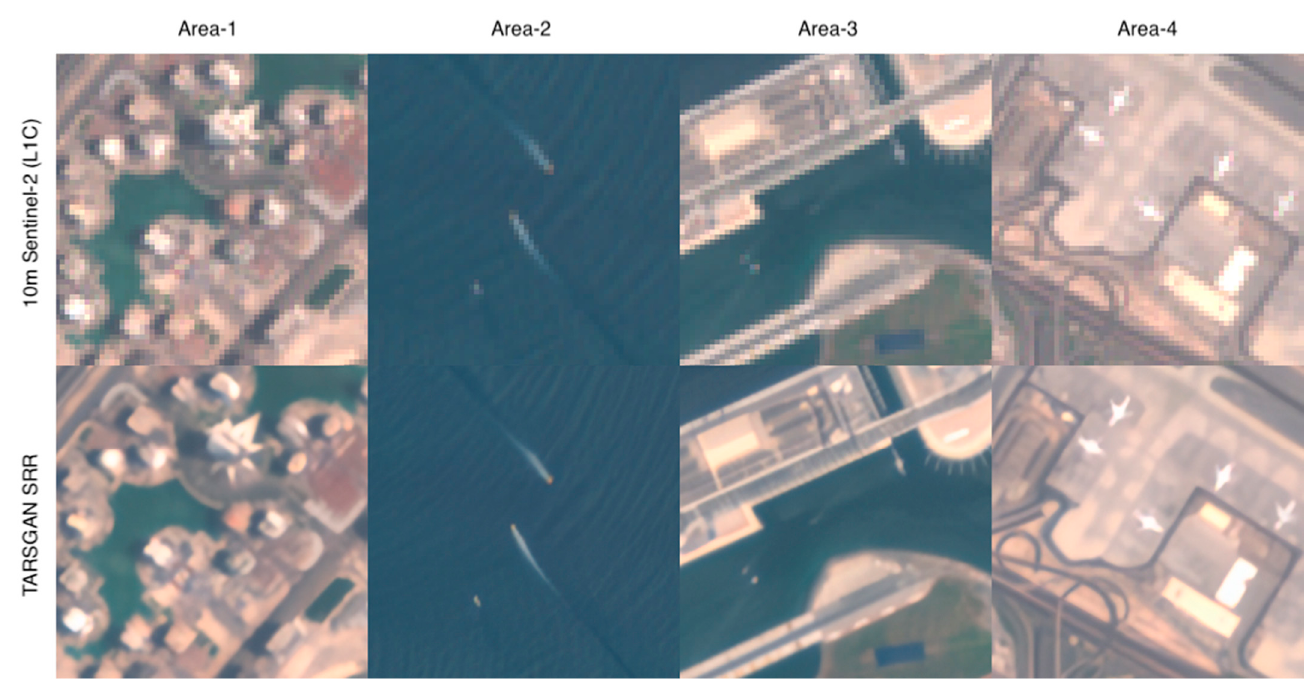
Figure 7. Cropped examples (625 m × 625 m ) of the 10 m/pixel Sentinel-2 “true” colour images (L1C) and TARSGAN SRR result over Baotou, China (Site-1). Please refer to Supplementary Material for full-size SRR (produced from Sentinel-2 S2A_MSIL1C_20171031T032851_N0206_R018 T49TCF_20171031T070327).